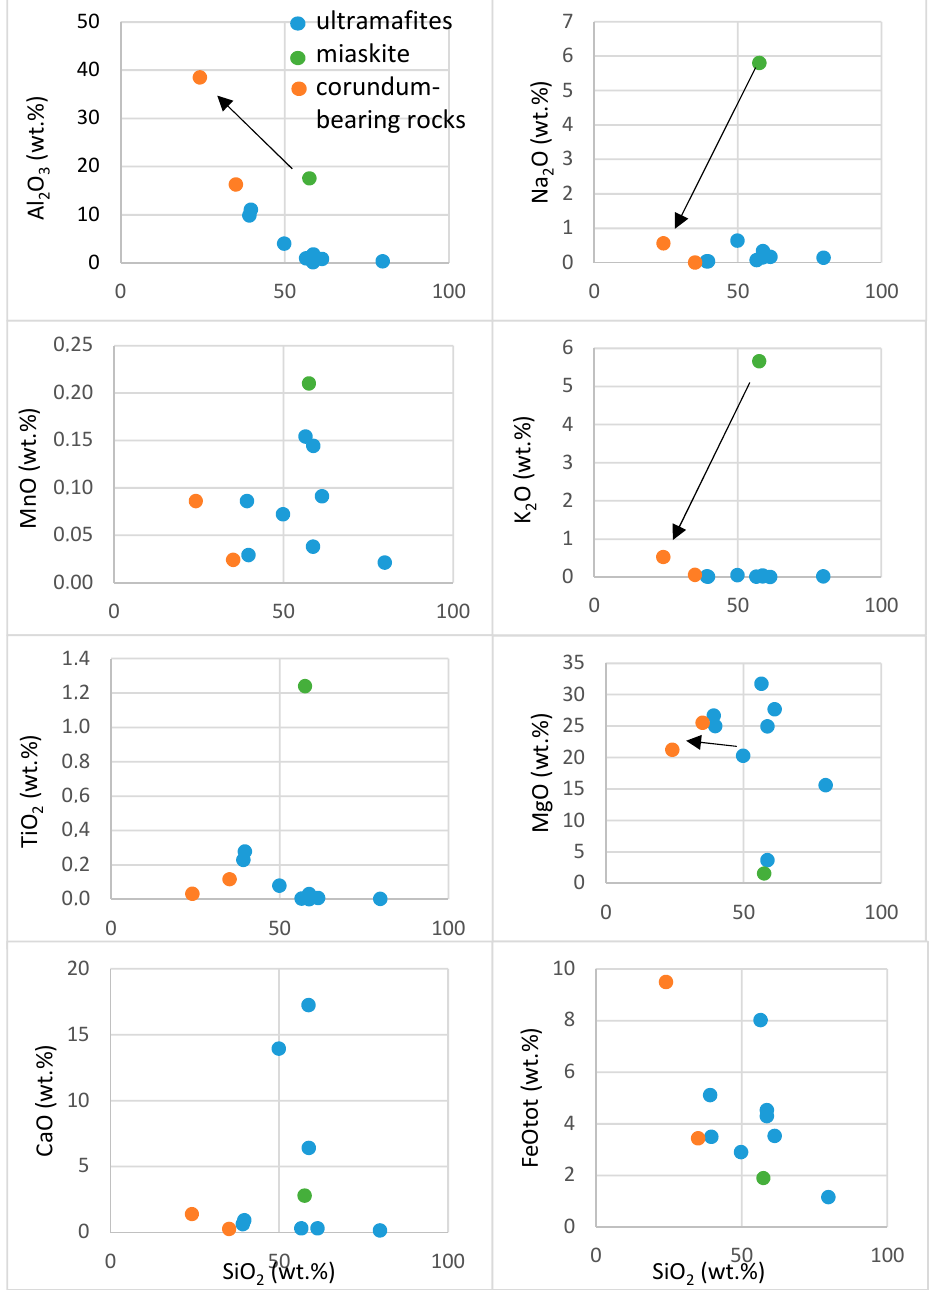
Figure 10. Variations of selected elements in whole-rock compositions from Table S13. Black arrows show the source of major elements of metasomatites. Chemistry of miascite is after [25]